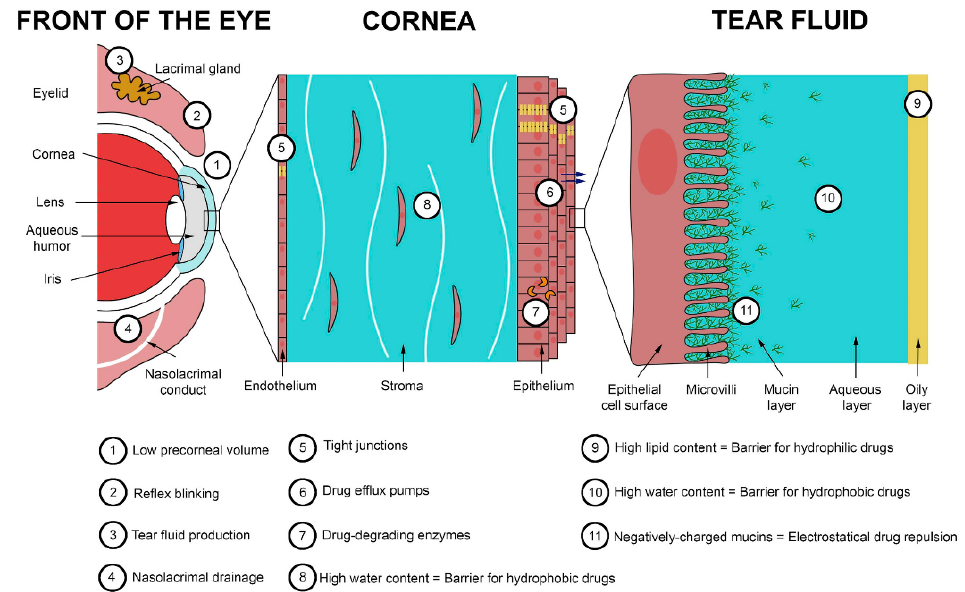
Figure 5. Main static and dynamic barriers for trans-corneal drug delivery [136]. Reprinted from Journal of Controlled Release , Volume 321, doi.org/10.1016/j.jconrel.2020.01.057. Clotilde Jumelle, Shima Gholizadeh, Nasim Annabi, Reza Dana. Advances and limitations of drug delivery systems formulated as eye drops. Reprinted with permission from ref. [136]. Copyright 2021